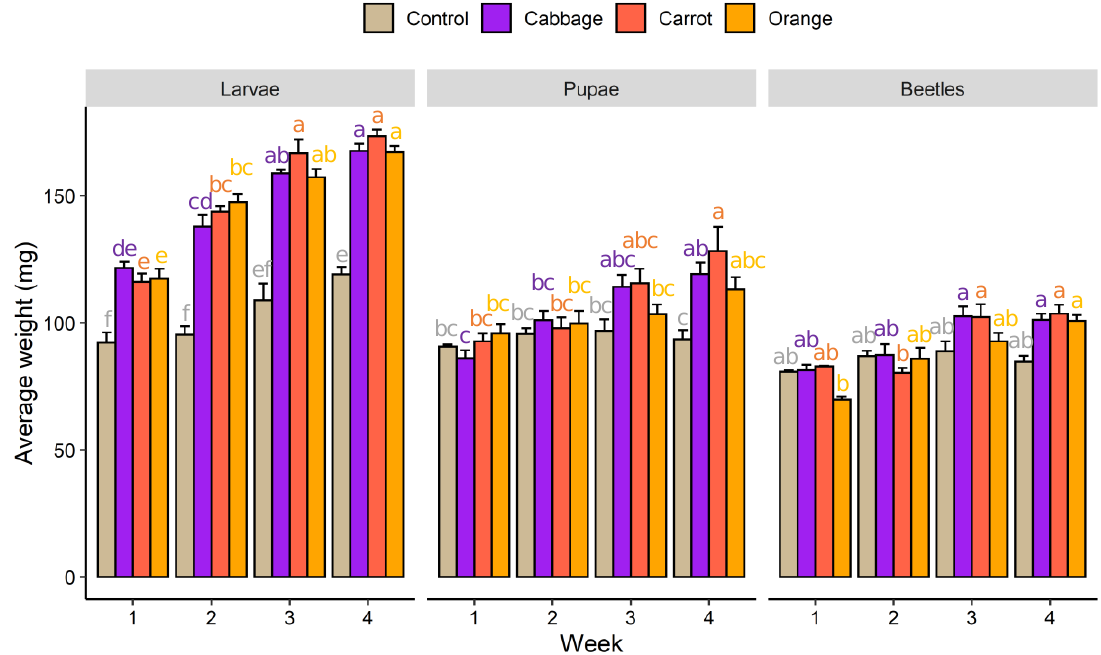
Figure 3. Average weight of mealworm larvae, pupae, and beetles fed on different diets. Means within each metamorphosis stage sharing no common letters differ significantly ( p < 0.05).